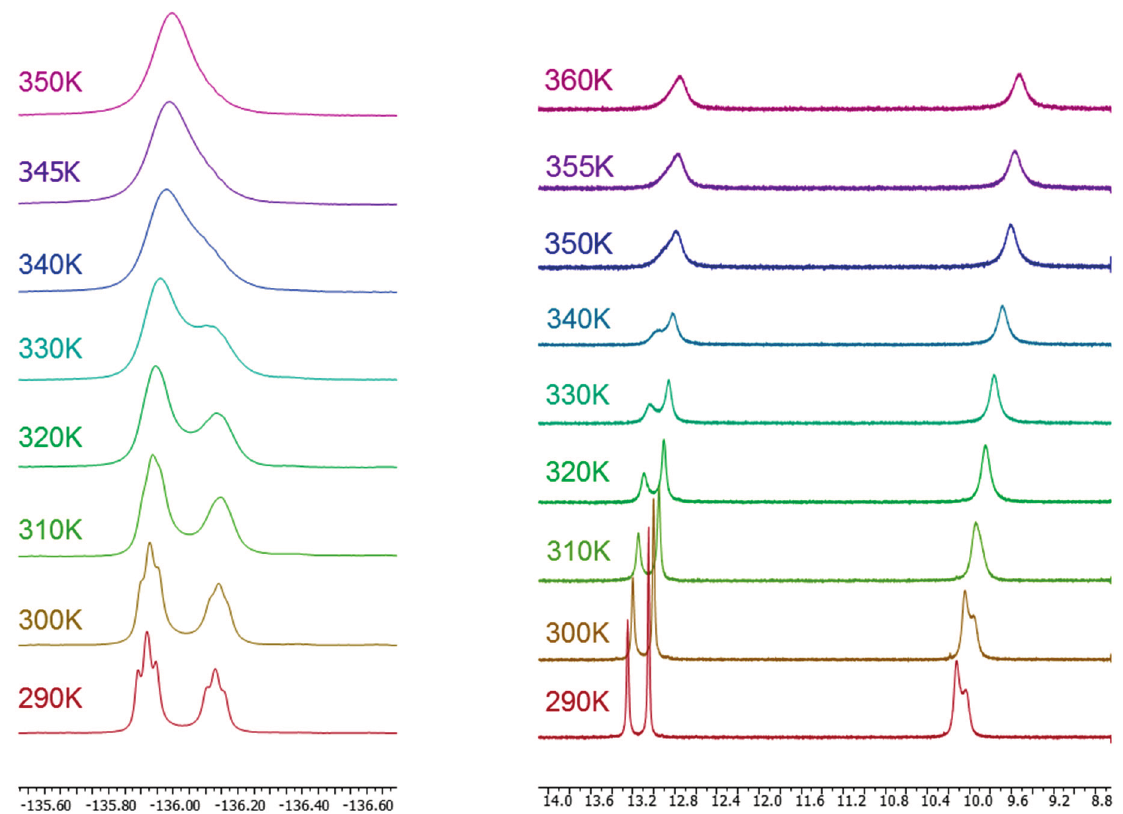
Figure 3. 19 F-NMR spectra ( left ) and 1 H-NMR spectra ( right ) of compound 13 in DMSO- d 6 (11 mg in 0.5 mL) in the temperature range of 290–360